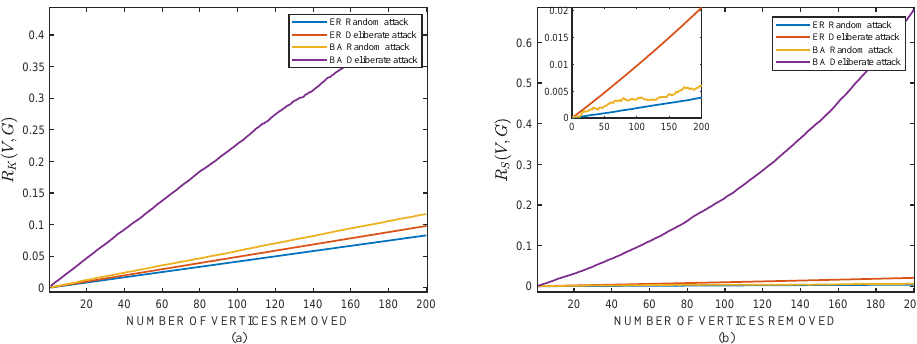
Figure 5. Experimental results of the two measures on the BA network and the ER network. For better presentation and observation of the data, the data here are averaged. ( a ) Deliberate and random attacks under the use of R K measures. ( b ) Deliberate and random attacks under the use of R S measures.